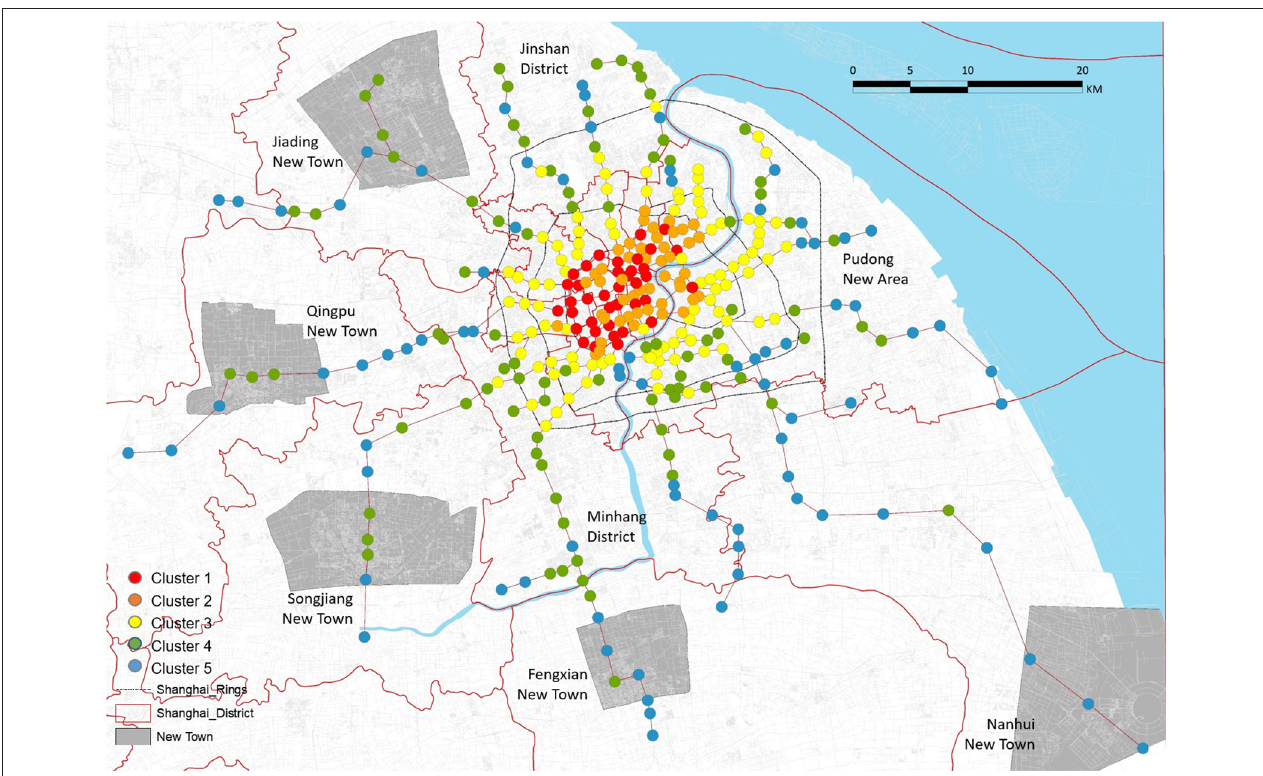
FIGURE 10 | TOD performance by clusters in Shanghai.